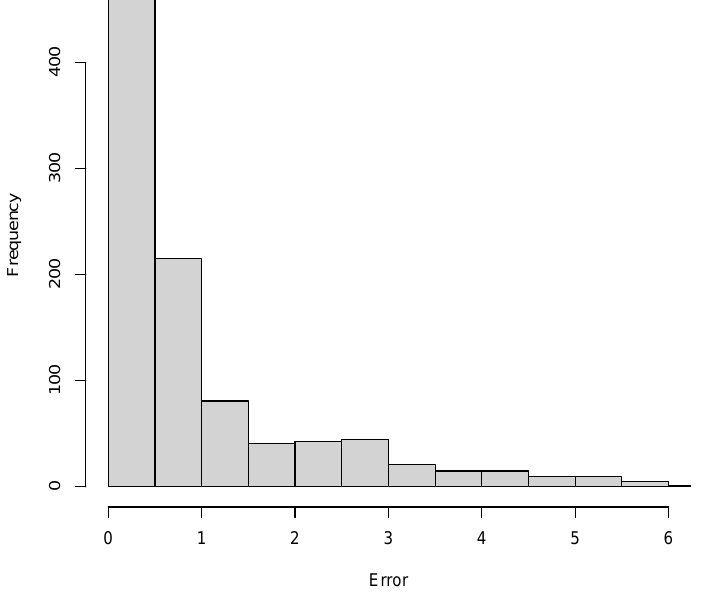
Figure 15. Histogram of the error ∆ 2